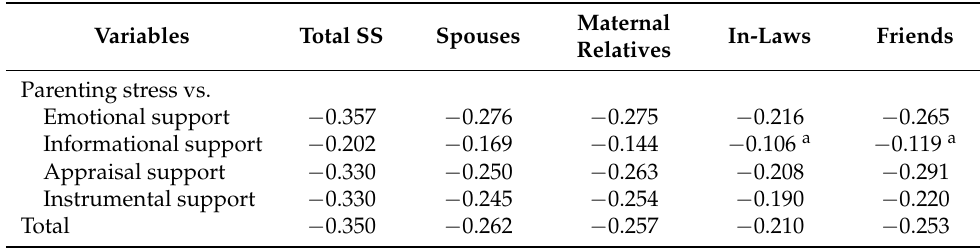
Table 3. Spearman’s rho between parenting stress, maternal confidence, and social support (SS) by types and sources ( N =